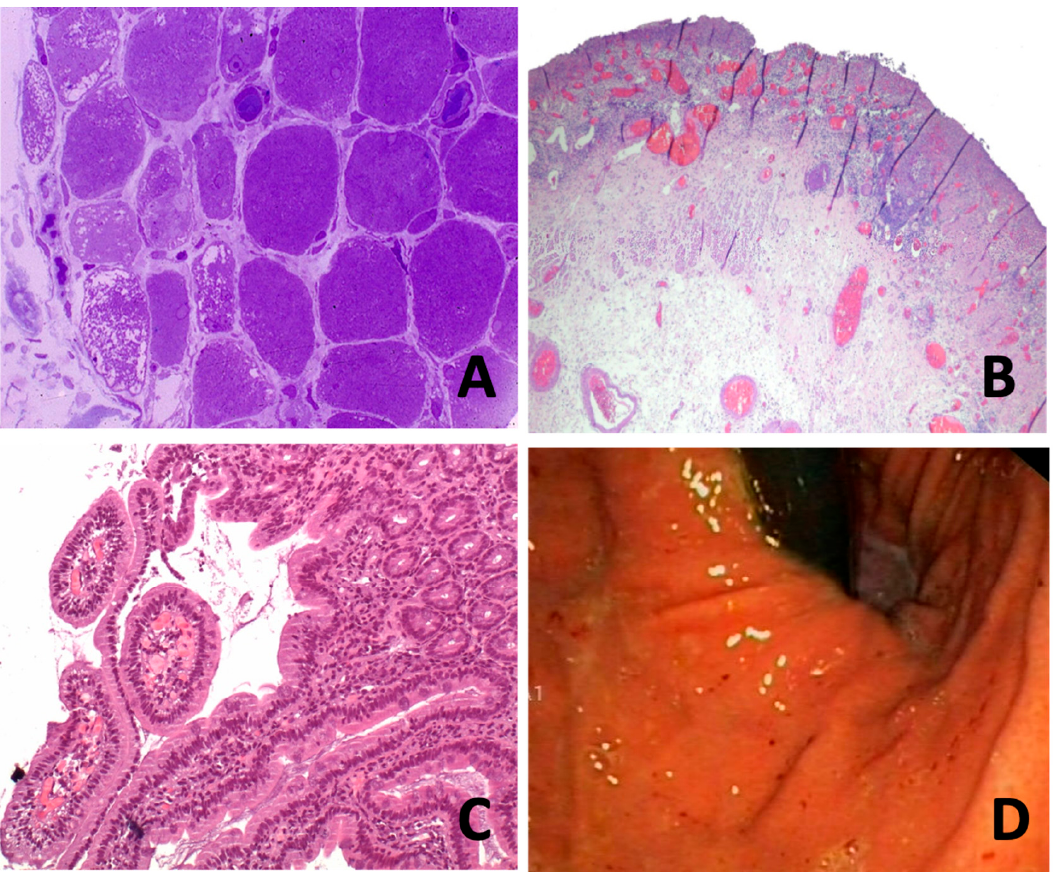
Figure 1. ( A ) (case 1): Plastic-embedded semithin cross-section muscle biopsy. Note the loss of capillaries in the peripheral area with mega- capillaries (star). ( B ) (case 2): Ulcerated mucosa area lined by granulation tissue, vascular ectasia and acute fibrinoleukocyitary inflammation. Some areas of the oesophageal wall with a moderate atrophy of the inner muscular layer with slight fibrosis and oedema. ( C ) (case 2) Mucosal inflammatory infiltrate with vascular ectasia extending to submucosa. Decreased glandular acini occupied by fibrin. ( D ) (case 3): Antral staking erythematosus without erosions or ulcerations evident. In the duodenum (from bulb to third duodenal portion), fibrin-coated erosions and well demarcated erythematous lesion with peripheral oedema is seen, without evidence of active bleeding.